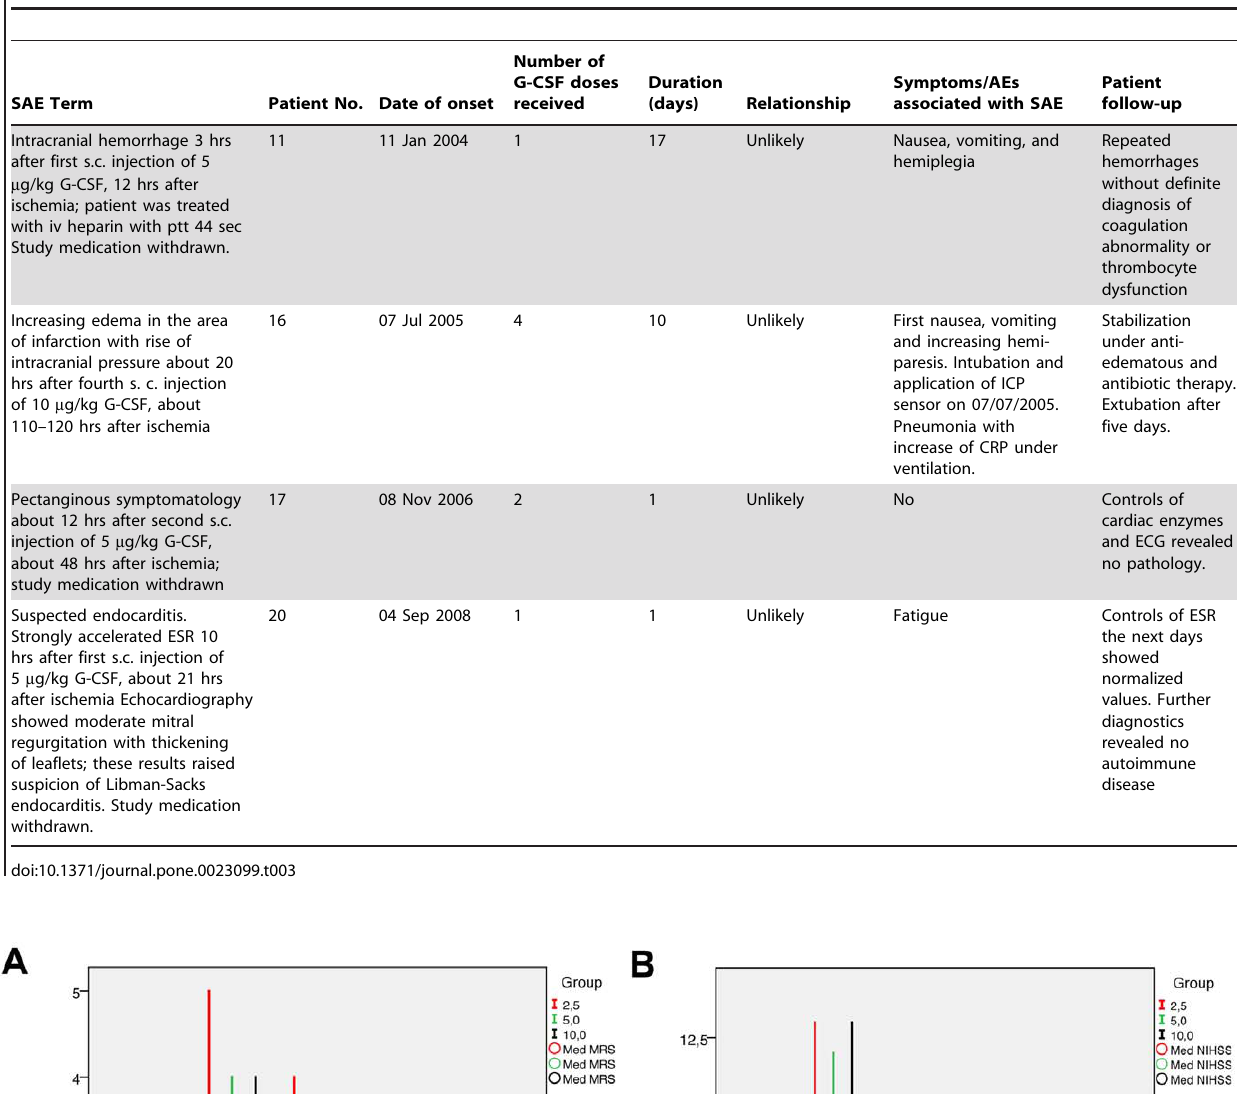
Table 3. Serious adverse events with time of onset, duration and outcome; ICP=intracranial pressure; ESR =erythrocyte sedimentation rate.